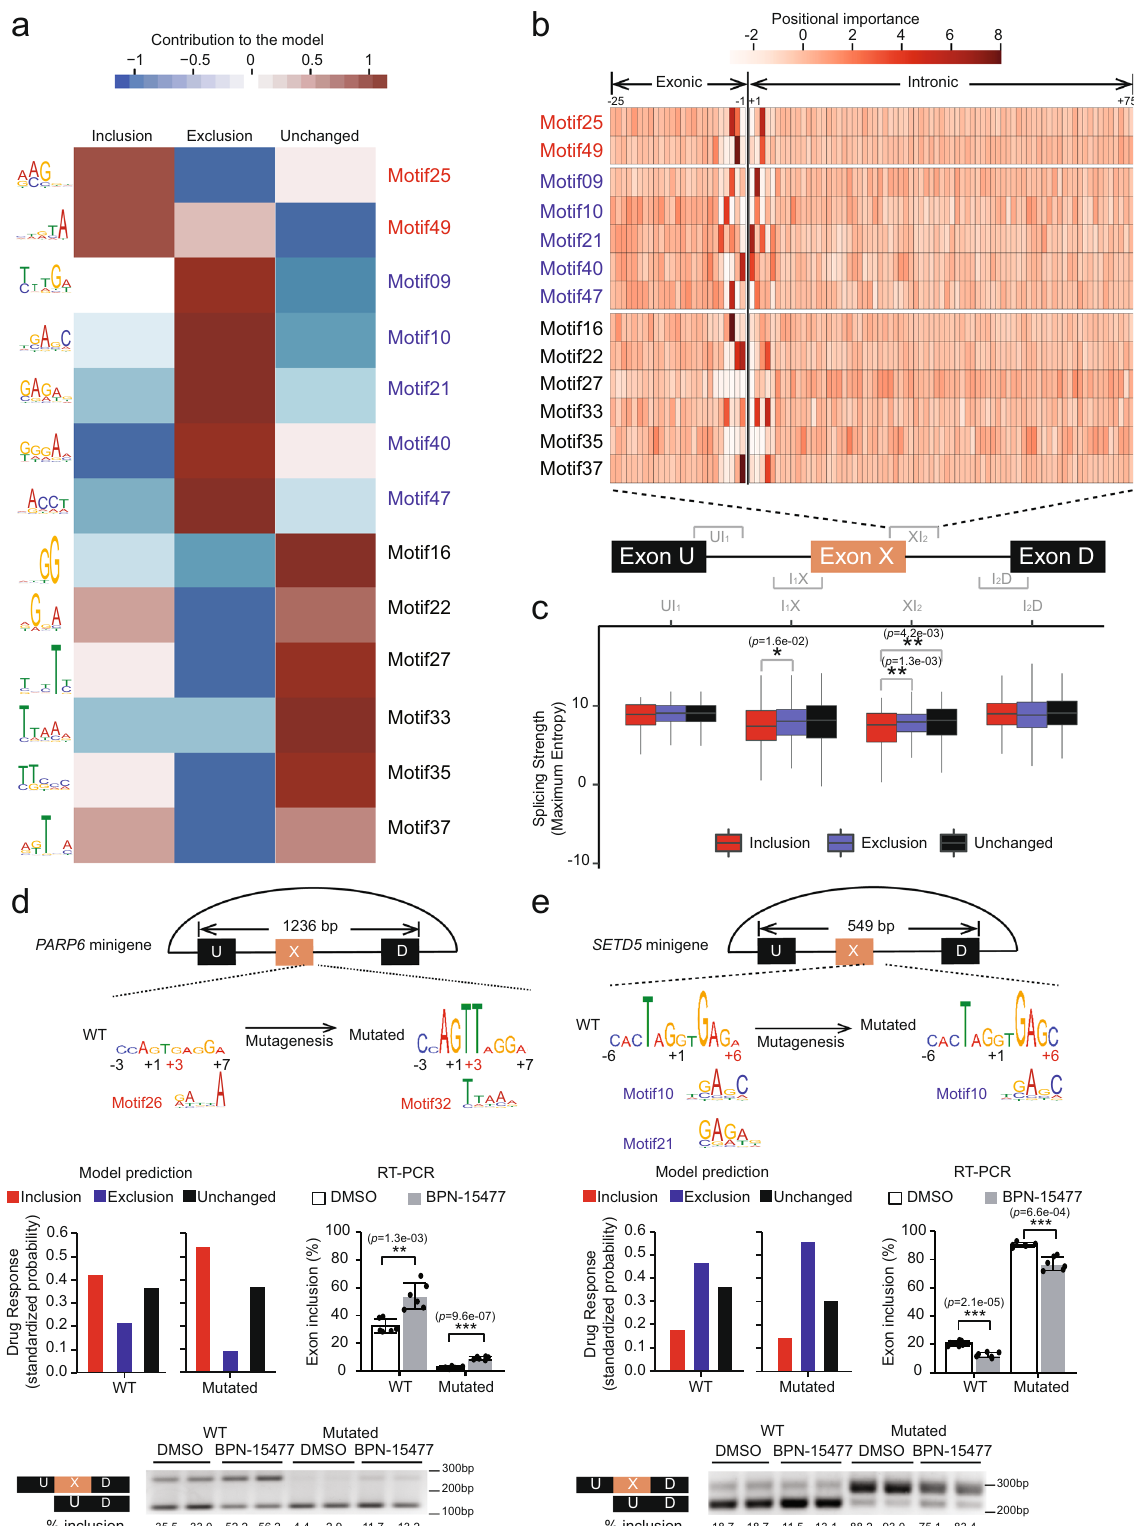
Fig. 4). To assess the robustness of the motifs identi fi ed by our CNN model, we compared the similarities of the 13 CNN- identi fi ed motifs with the most enriched fi ve-nucleotide combi- nations (5-mer) at 5 ′ splice sites of the middle exons in our training set. The 5-mer sequence enrichment analysis for nucleotides at positions − 3 to + 7 of 5 ′ splice sites was